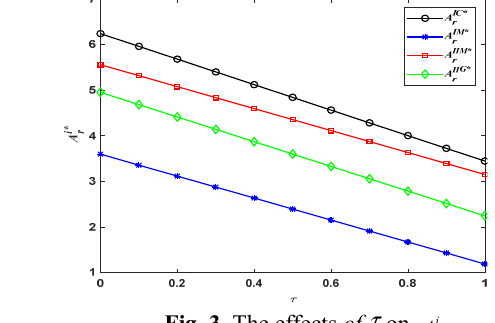
Fig. 2. The effects of τ on i e . Fig. 3. The effects of τ